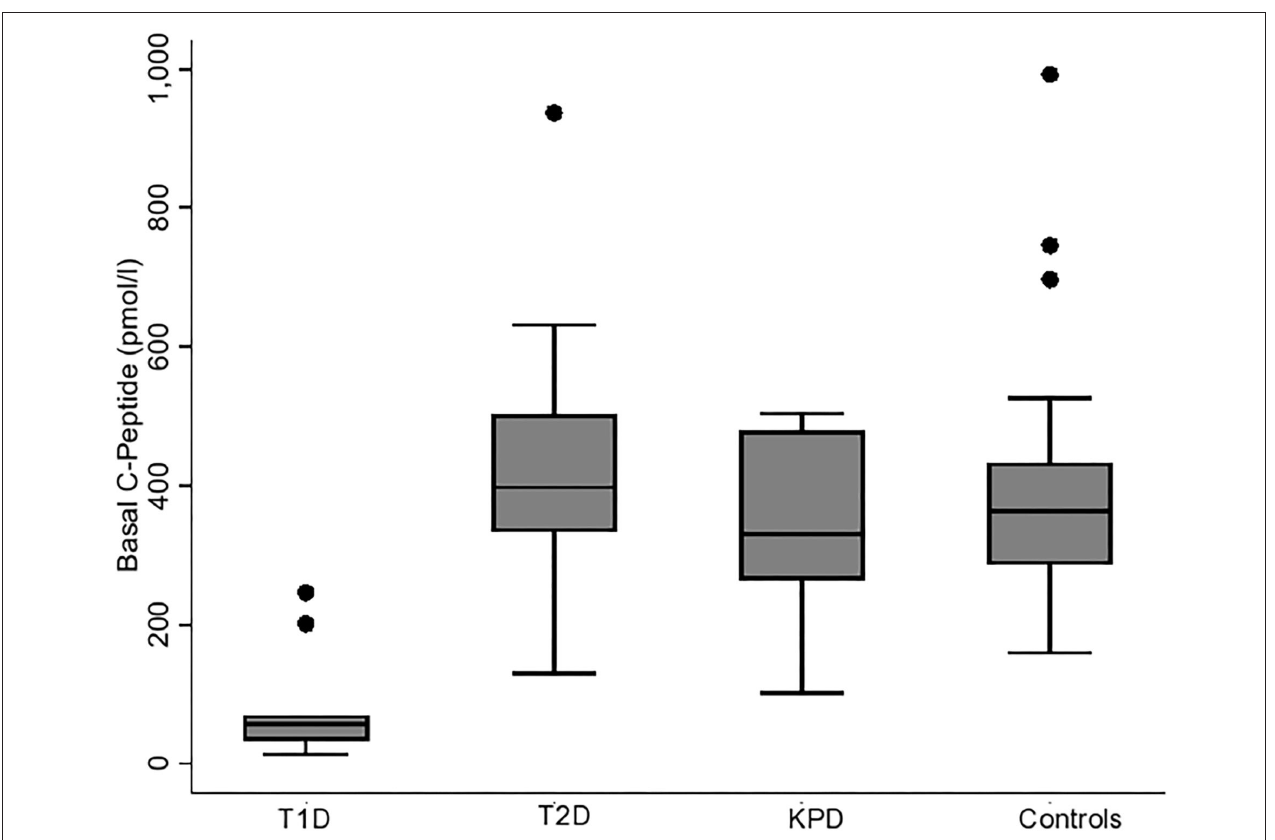
FIGURE 1 | Boxplot showing the basal C-peptide levels in the different categories of participants. The error bars represent the standard